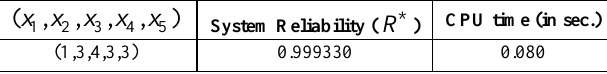
Table 1. Computational